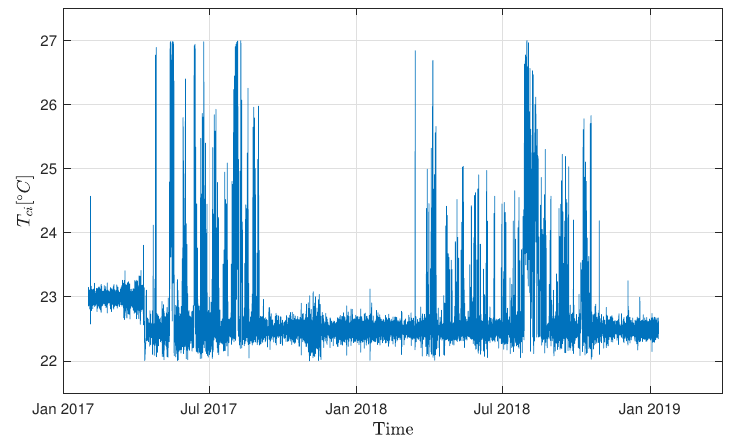
Figure 8. Condenser inlet water temperature time series.